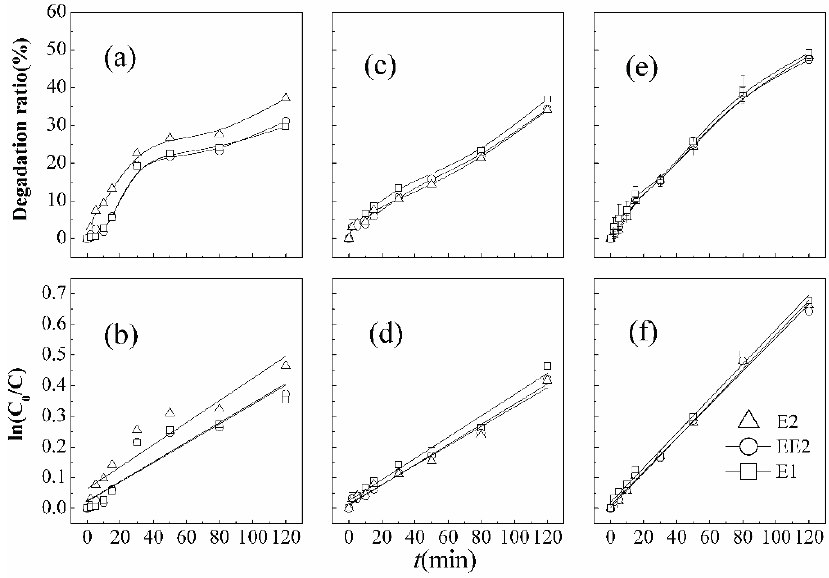
Figure 3. Degradation curves and first order kinetic models of SEs in different treatment processes (( a ), ( b ) single ultrasound; ( c ), ( d ) single KMnO 4 ; ( e ), ( f ) combined KMnO 4